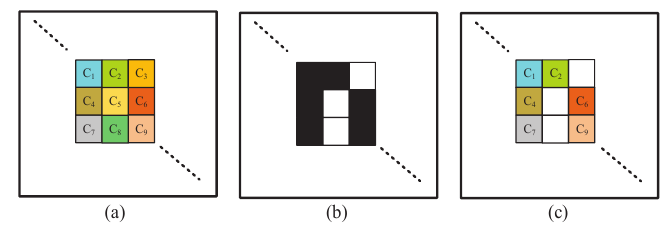
Figure 6. Block patterns: ( a ) 9 color pixels with color C 1 − C 9 in CCI (cid:48) ( b ) the corresponding block B ( i ) in NS i ( c ) the corresponding color block in CS (cid:48) i